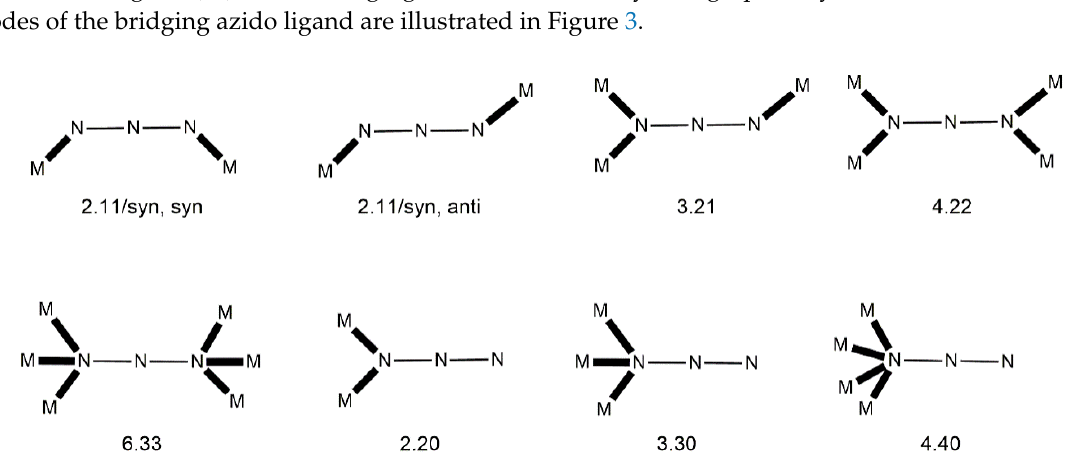
Figure 3. The to-date crystallographically established bridging coordination modes of the azido ligand and the Harris notation [61] that describes these modes. Coordination bonds are drawn with bold lines.